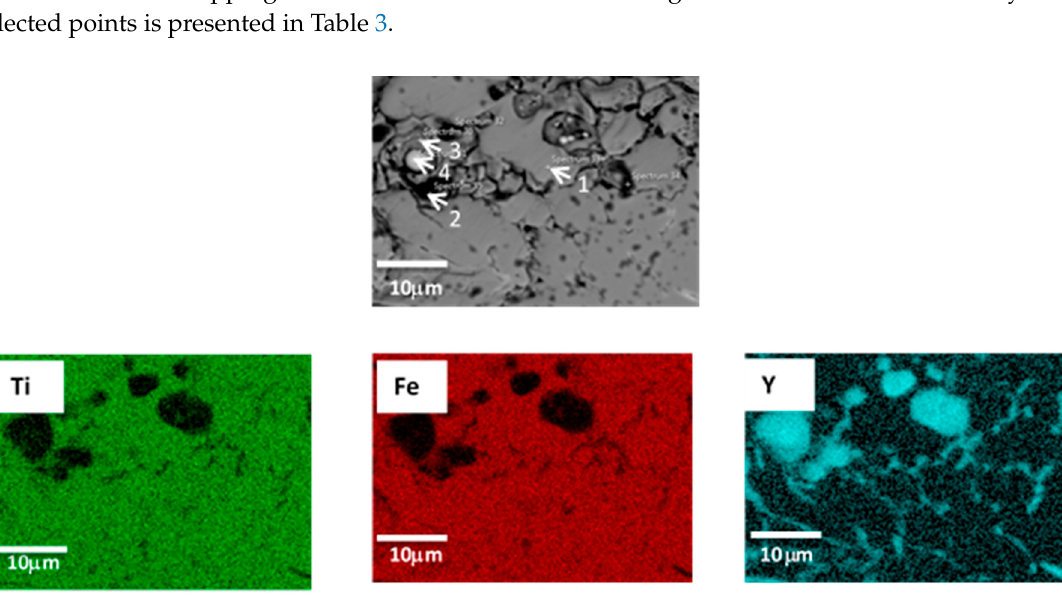
Figure 3. Backscattered micrographs of TiFe + 6 wt.% Y and the corresponding EDX mapping.